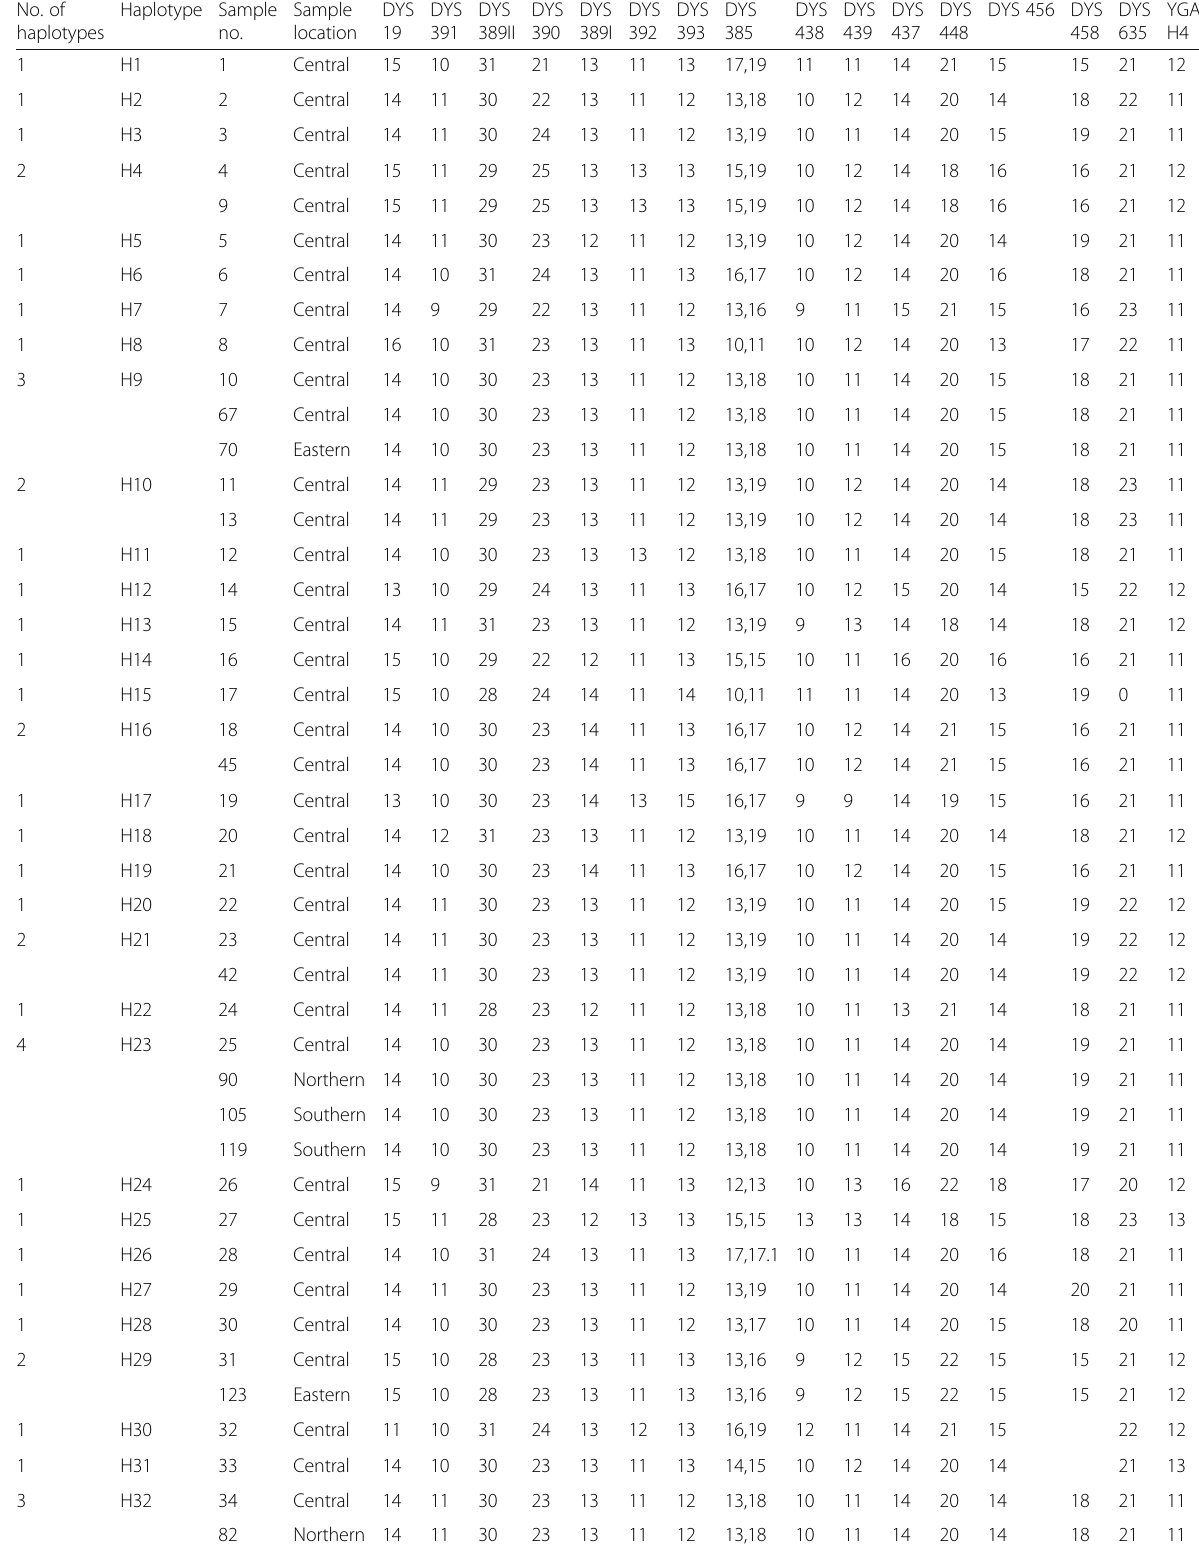
Table 2 Y chromosome haplotype analysis of 17-YSTR markers in male Saudi population ( n = 125) No. of Haplotype Sample haplotypes